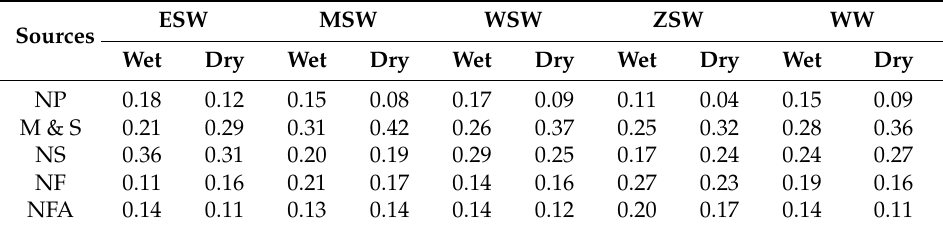
Table 4. Mean probability estimates of source contributions apportioned by SIAR (Stable Isotope Analysis in R). ESW means Eastern sub-watershed; MSW for Middle sub-watershed; WSW for Western sub-watershed; and ZSW for Zhuyuangou sub-watershed; Wet means nitrate proportional contributions during wet season; Dry means nitrate proportional contributions during dry